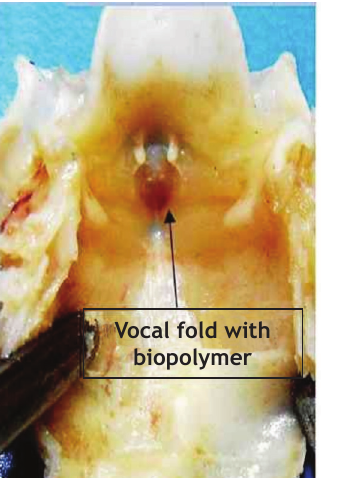
Figure 3 Photograph of rabbit larynx after 3 weeks of SCB implantation in the right vocal fold. Macroscopically, we obser- ve the deletion of the groove between the vocal fold and the ipsilateral ventricular